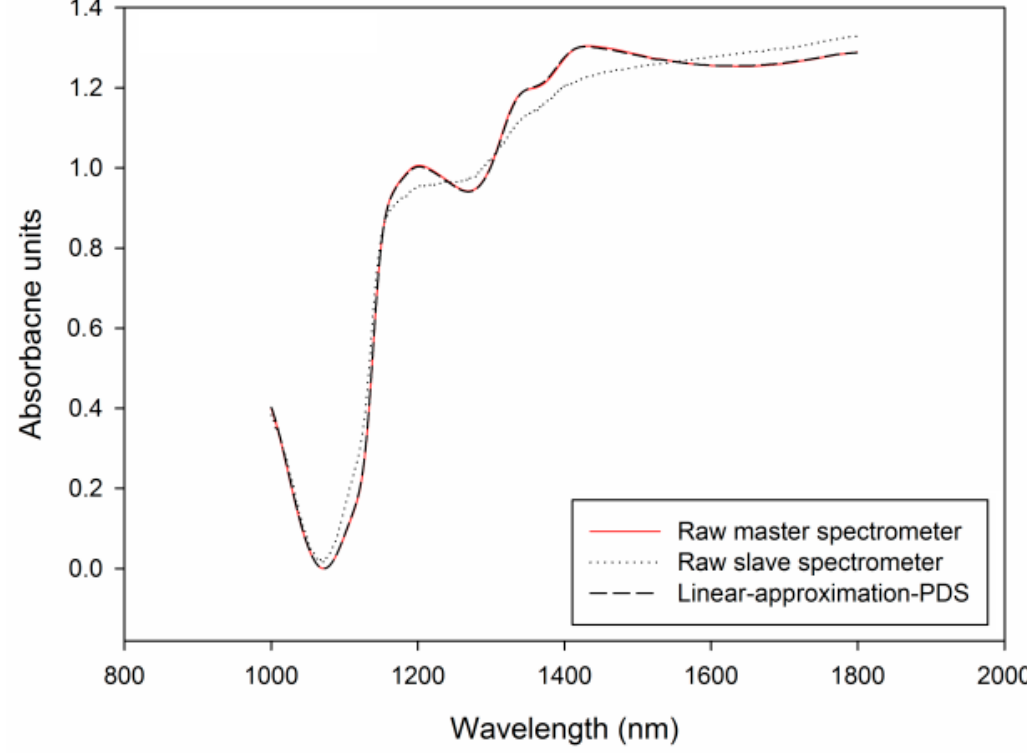
Figure 6. The average spectra of prediction sets for Ruby Seedless in the range of 1000–1800 nm.